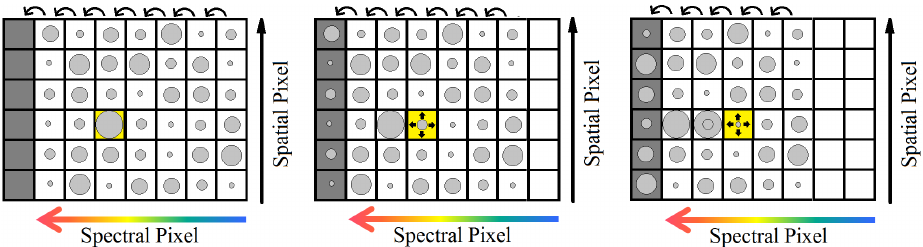
Fig. 4: Illustration of the read-out process and the smear effect. The grey bar on the left side illustrates the read-out unit. The arrows indicate the shifting direction of the photo-electrons. The magnitude of the signal of each pixel is indicated by the size of the circles. The smear effect is illustrated for one spatial pixel which is exposed to additional illumination at one spectral pixel (yellow) during the read-out process.